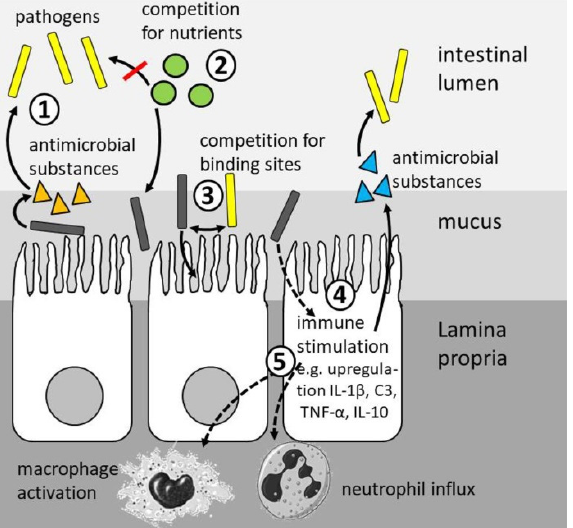
Figure 3. Health- and disease-resistance-related effects (modes of action) of probiotics in the gas- trointestinal tract (GIT), including direct effects such as (1) secretion of antimicrobial substances, (2) competition for nutrients, and (3) binding sites, as well as (4) indirect effects such as stimulation of immune parameters and (5) activation of macrophages and the influx of neutrophils. For further details, refer to the text.